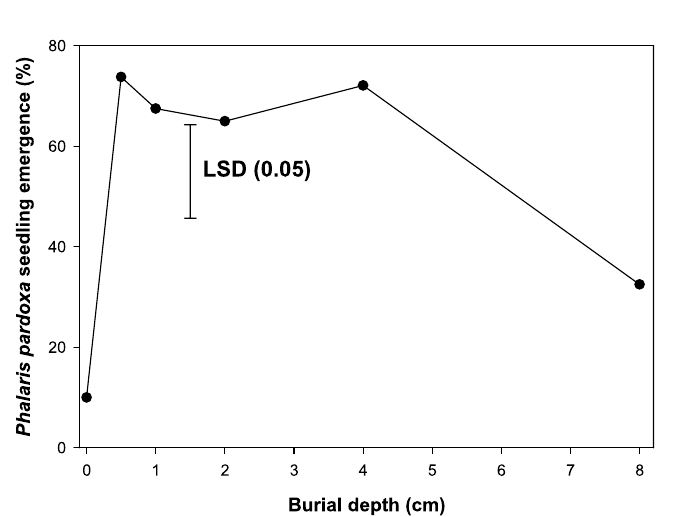
Figure 5. Effect of seed burial depth on seedling emergence of Phalaris paradoxa. LSD: Least significant difference at the 5% level of